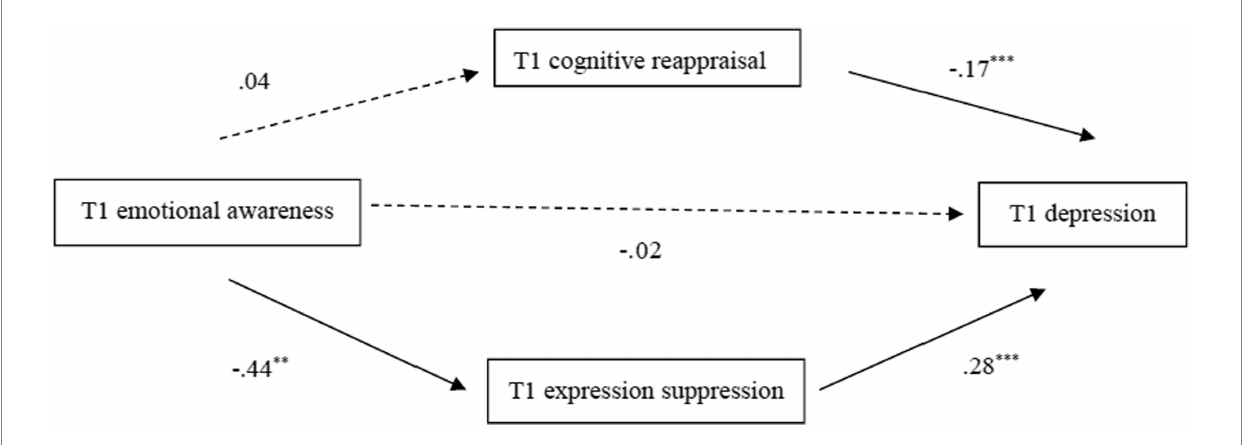
FIGURE 1 Mediating model of emotion regulation strategies between T1 emotional awareness and T1 depression. Straight lines represent the coefficient is significant. Dashed lines represent the coefficient is not significant. The coefficient from emotional awareness to depression below the center horizontal path represents the direct effect. ** p < 0.01, *** p < 0.001.